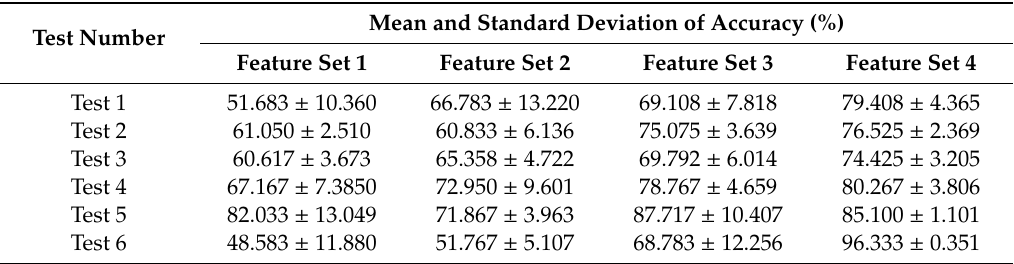
Table 5. Accuracy (mean and standard deviation, %) of external testing under different test number.